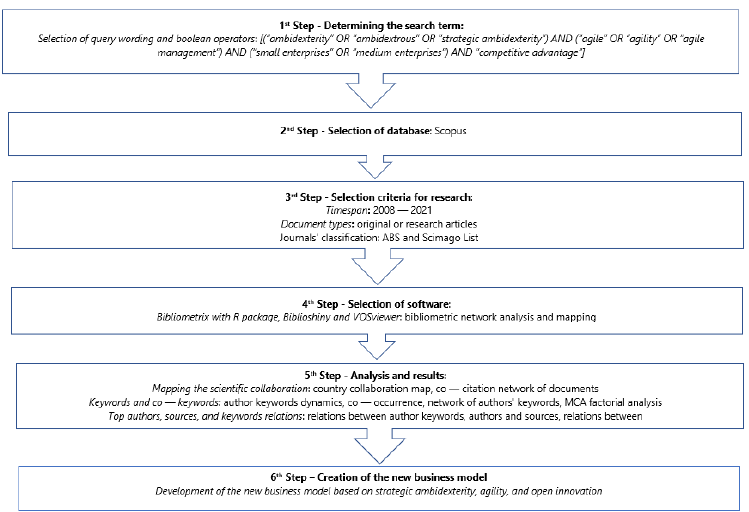
Figure 1. Methodological flow. Source: Own elaboration.